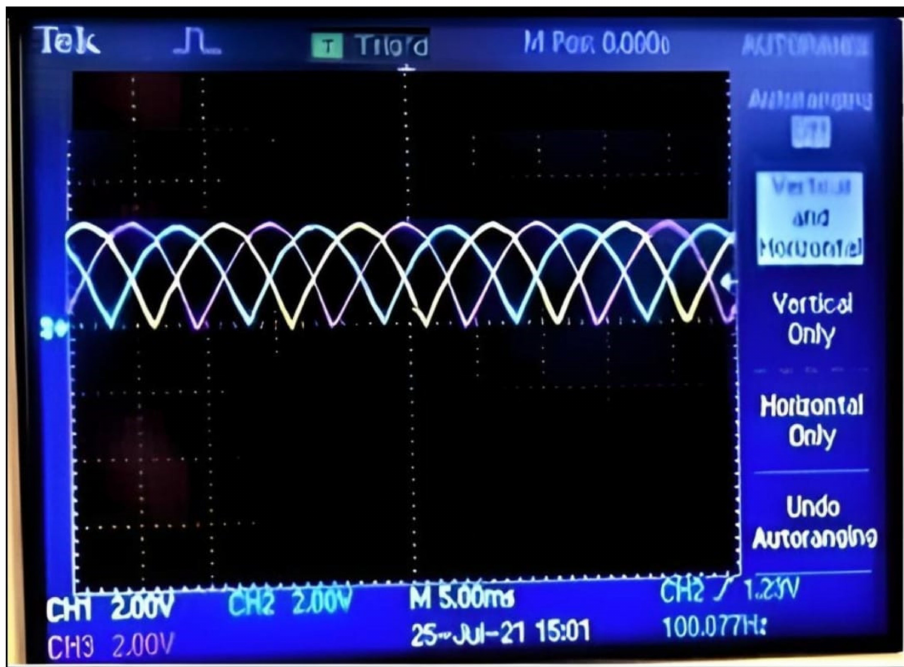
Figure 18. The rectified signal is sensed from the grid